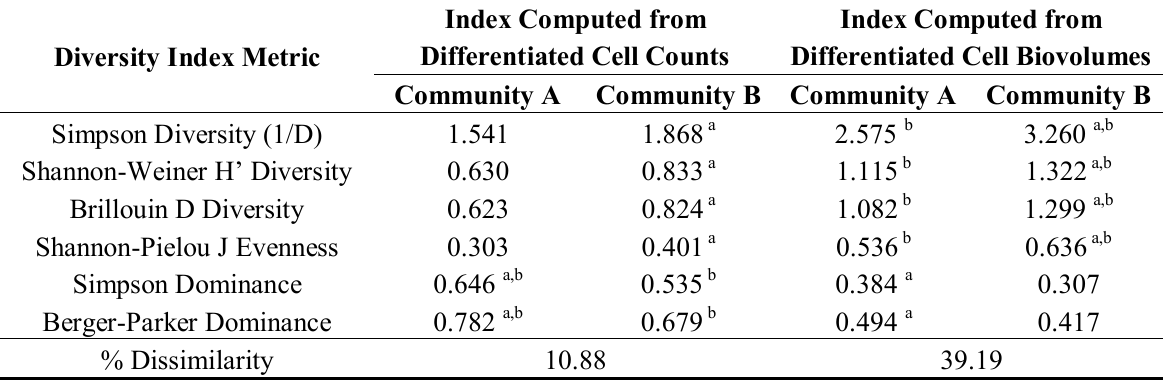
Table 3 . Indices of diversity, evenness, dominance and dissimilarity for communities A and B. Statistically significant ( p < 0.05) higher values are indicated with superscript a in the comparison of communities A vs . B when using the same morphotype abundance metric (e.g., community A vs . B using cell counts), and are indicated with the superscript b in the comparison of counts vs . biovolume as the abundance metric for the same community (e.g., comparing cell counts vs. biovolume for Community